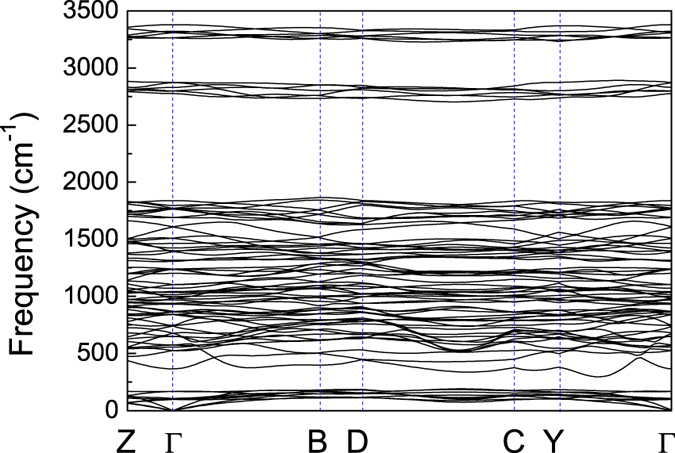
Phonon spectrum.Calculated phonon spectrum of C2/m structure at 200 GPa.